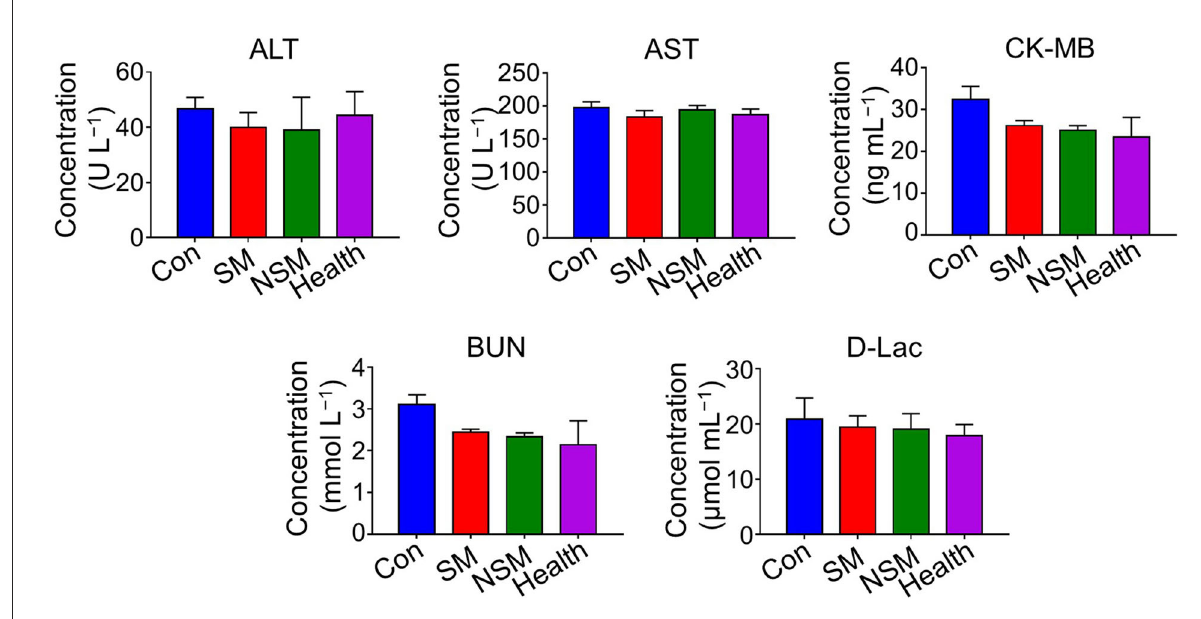
FIGURE5 Biochemical analyses in subcutaneous colon cancer mice